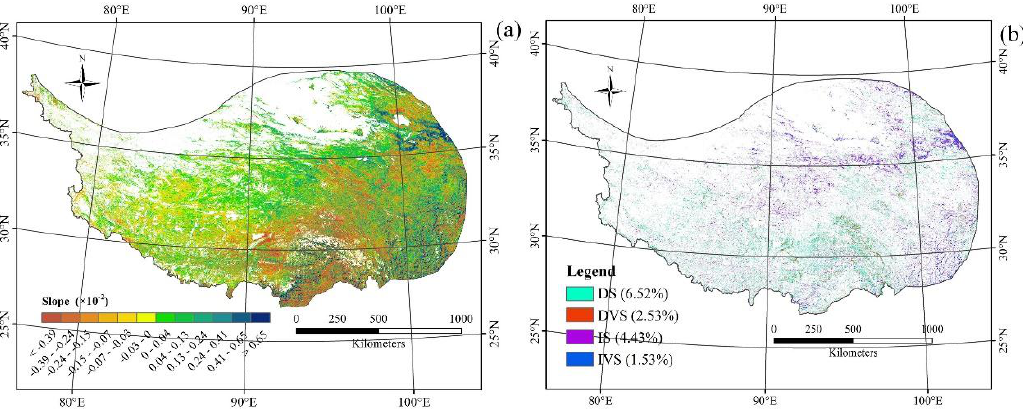
Figure 3. ( a ) Trends in annual NPP within the Tibetan Plateau between 2001 and 2015, where negative values indicate a decreasing trend of NPP, and vice versa; and ( b ) very significant ( p < 0.01) and significant ( p < 0.05) trends for NPP variation. DS, decreased significantly; DVS, decreased very significantly; IS, increased significantly; IVS increased very significantly. Values in parentheses show the percentage of significant pixels at p < 0.05.